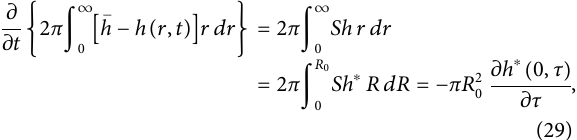
10 f . In the extreme case when the total volume of fl uid (cid:1) removed is V (cid:2) 0 . 99 ( π R 2 h ) , then P (0, ∞ ) = 100 f . In other 0 words, it is the removal of the last vestiges of the original mass inside R 0 that spins up the PV to such large values. This effect given by Eq. 31, for the time range 0 ≤ τ ≤ 72 h and for the fi xed volume parameter V (cid:2) 3 . 174 × 10 13 m 3 . The nine curves correspond to combinations of the three choices τ s = 3, 6, 12 h and the three choices R 0 = 200, 300, 400 km, the latter of which give ϵ = 0.990, 0.440, 0.248. The nine curves illustrate the sensitivity of the core PV to the value of R 0 for fi xed V